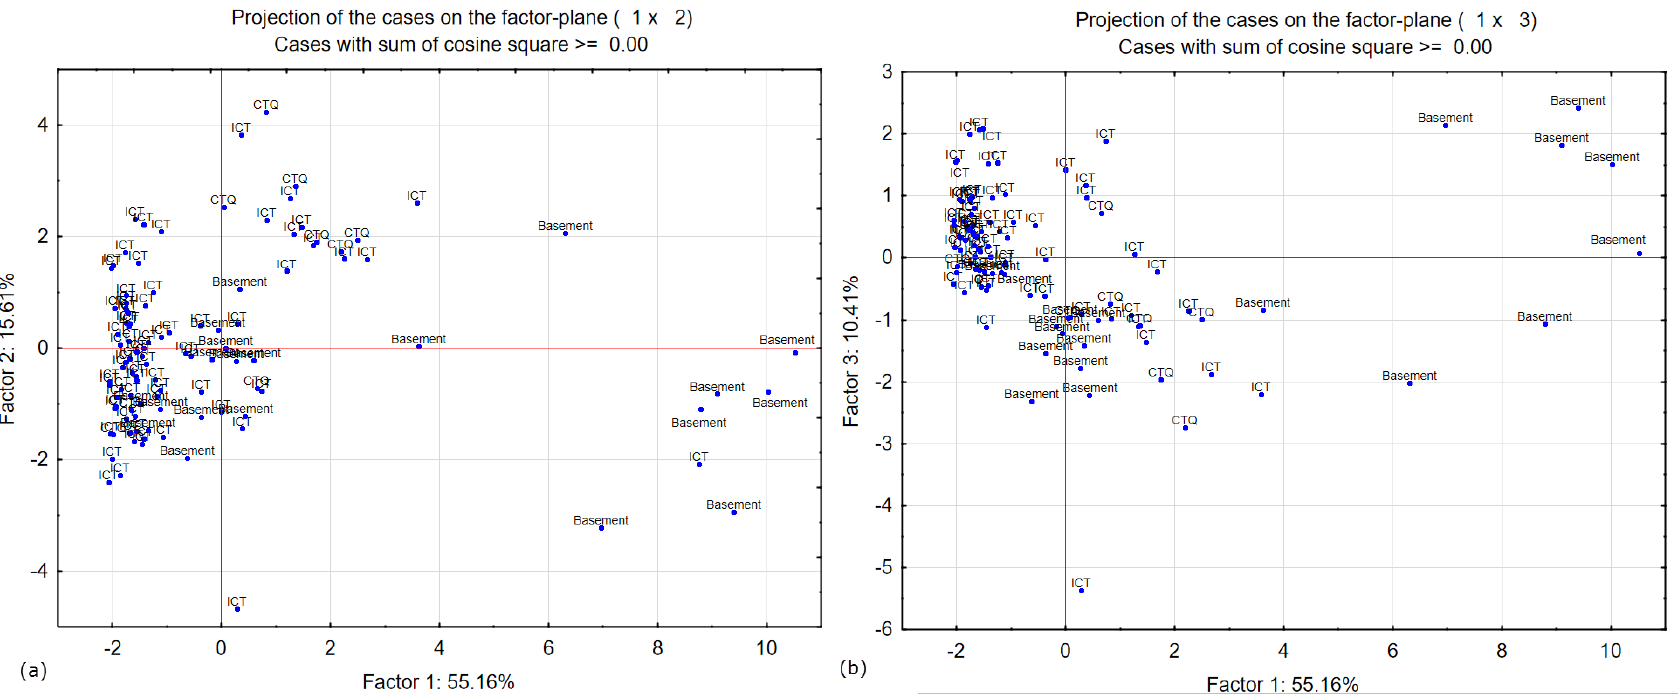
Figure 11. Space of the statistical units of the factorial plane: ( a ) F1-F2; ( b ) F1-F3.